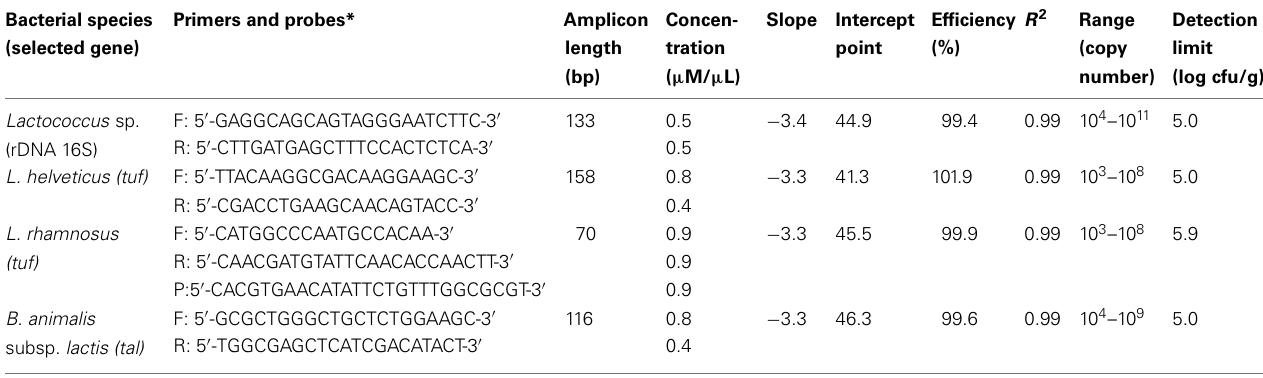
Table 2 | qPCR primers, efficiency, and detection limits for all bacterial species. Bacterial species